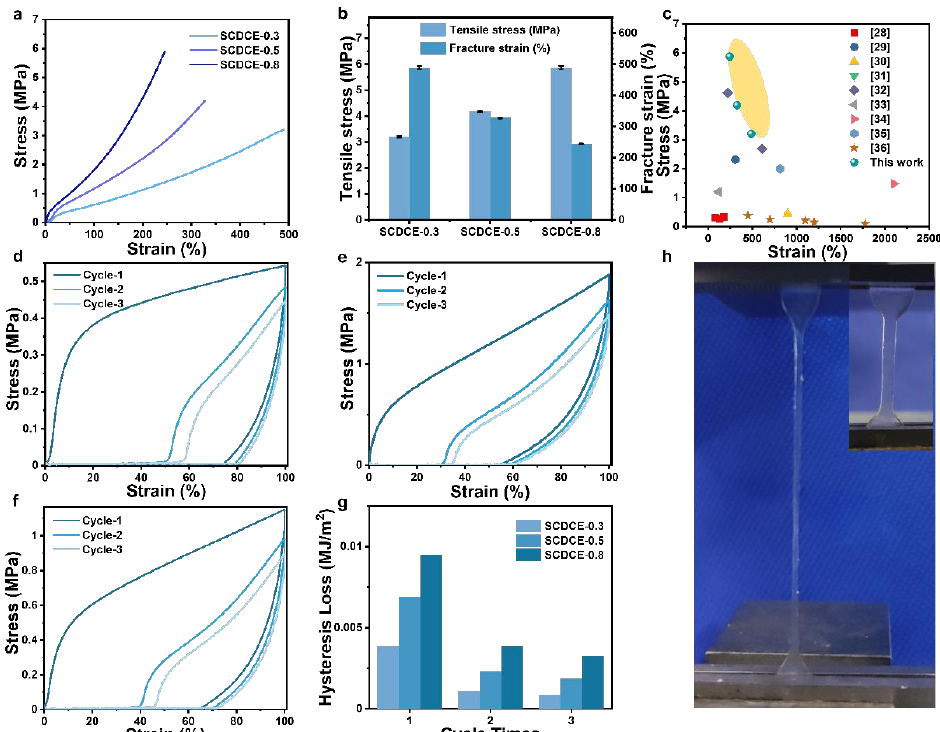
Figure 4. Mechanical properties. ( a ) Tensile tests of SCDCEs samples at a strain rate of 0.083 s − 1 . ( b ) Summary of mechanical properties of the SCDCEs. ( c ) Ashby plot of the mechanical properties of SCDCEs and recently reported acrylate-based elastomers [28 – 36]. Cyclic stress – strain curve of SCDCE-0.3 ( d ), SCDCE-0.5 (e) and SCDCE-0.8 ( f ). ( g ) Schematic photo of SCDCEs stretching process.